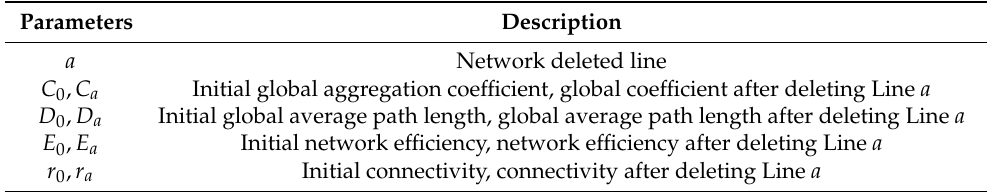
Table 5. Description of Formula parameters.